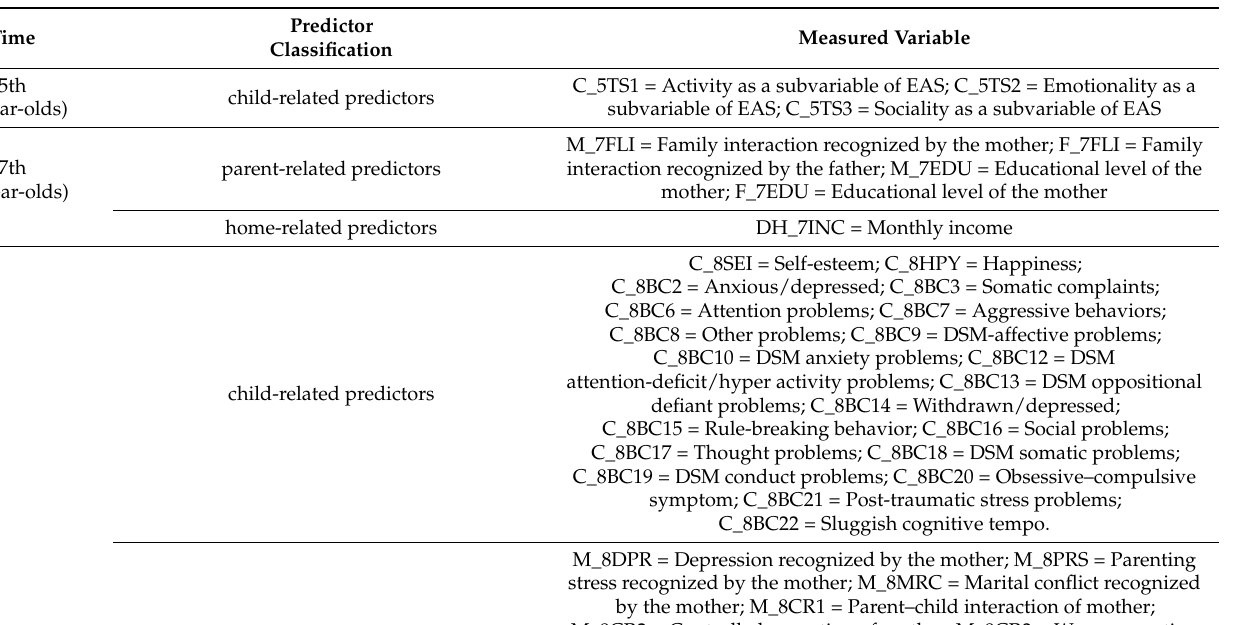
Table 1. Variables measured over